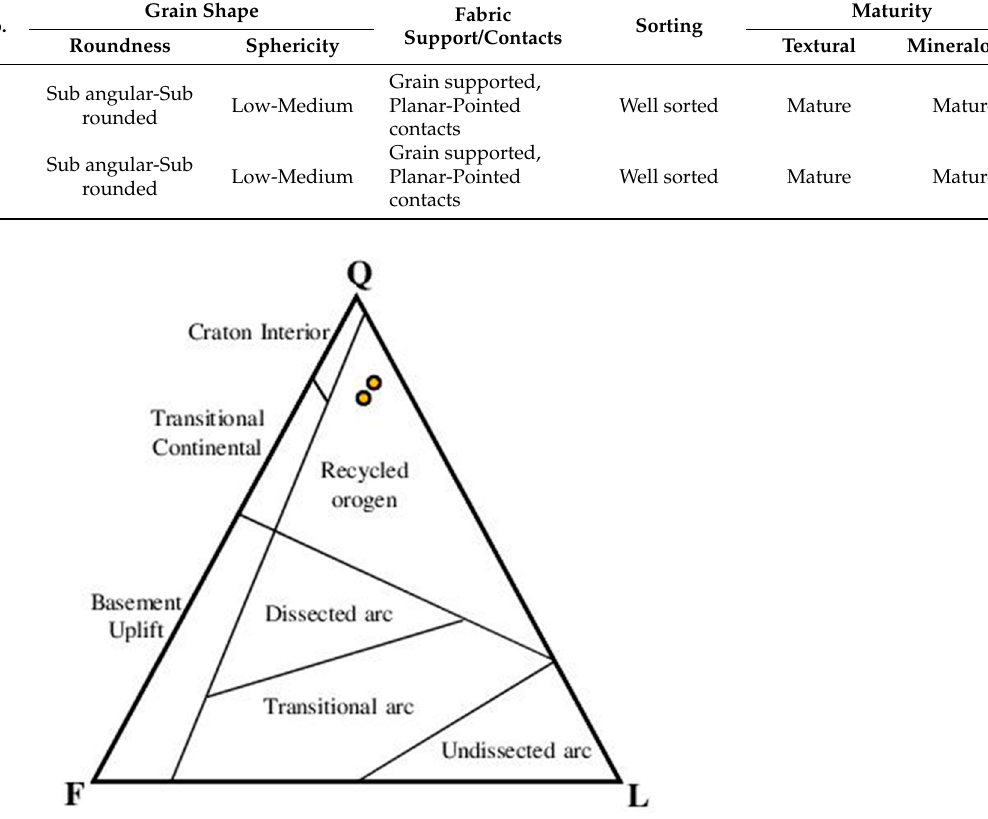
Figure 4. Ternary diagram showing tectonic discrimination of the studied sandstone samples [42]. Where Q—total quartz, F—feldspar, and L—lithics. Table 1. Petrographic data of studied samples and percentage compositions of the framework grains. Where, Qm—monocrystalline quartz, Qp—quartz polycrystalline, Pf—plagioclase feldspar, Af—alkali feldspar, F—total feldspar, Ls—sedimentary lithics, Lm—metamorphic lithics, Li—igne- ous lithics, L—total lithics, and Q—total quartz.